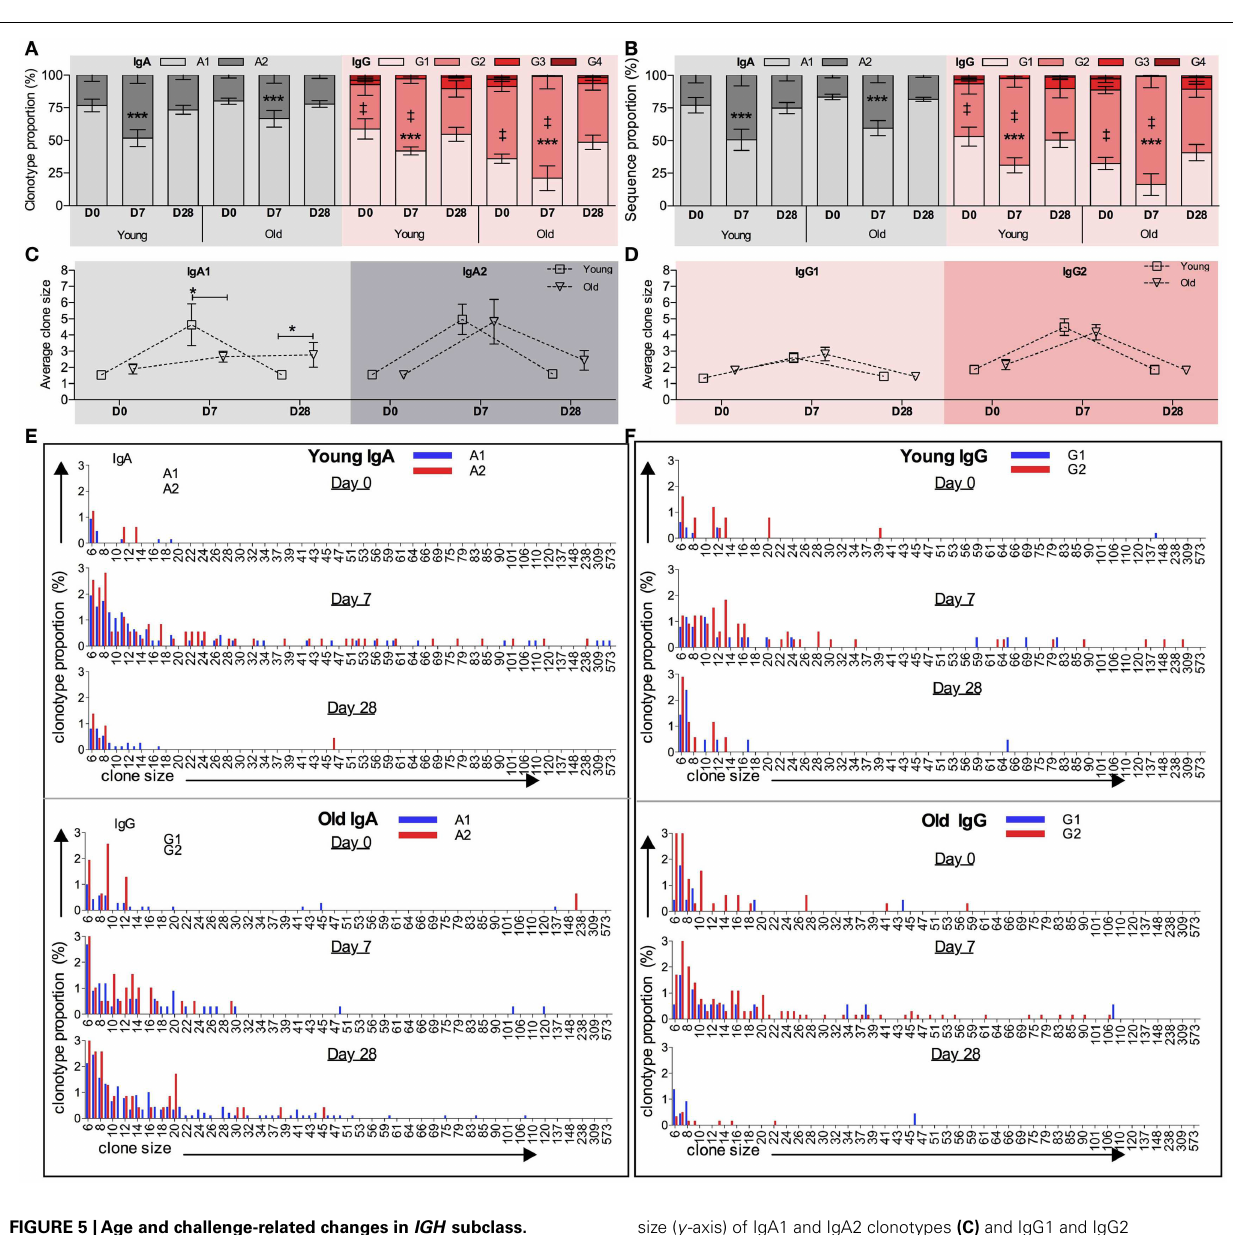
FIGURE 5 |Age and challenge-related changes in IGH subclass. Internal motifs in the constant region were used to identify subclasses (IgA1, IgA2, IgG1, IgG2, IgG3, and IgG4) in each IGH sequence.The proportion ( y -axis) of clonotypes clustered by CDR-H3 (A) and total sequences (B) of different IgA or IgG subclasses at D0, D7, and D28 was calculated for each donor individually before being collectively analyzed (temporal differences: *** p < 0.0005 using repeated measures ANOVA when compared with D7; age-related differences: ‡ p < 0.005 using Mann–Whitney U- tests). Error bars indicate ± SEM.The average clone